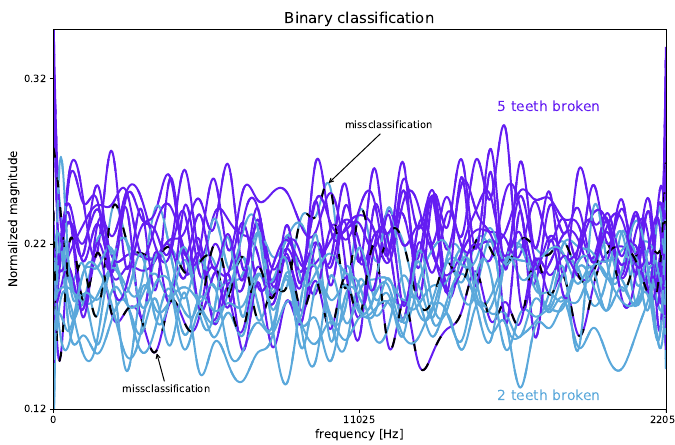
Figure 9. Binary classified validation subset. The graph shows the predicted classes for all samples. Misclassifications are highlighted by black dashed lines and additionally pointed out by black arrows.